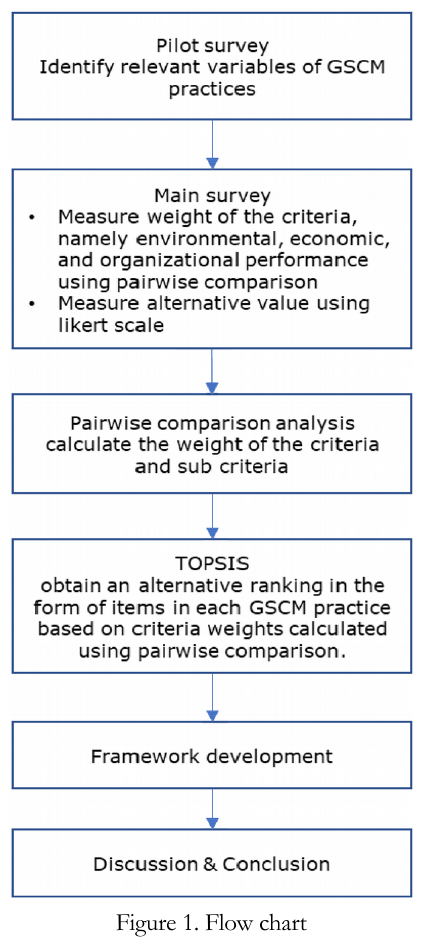
Figure 1. Flow chart